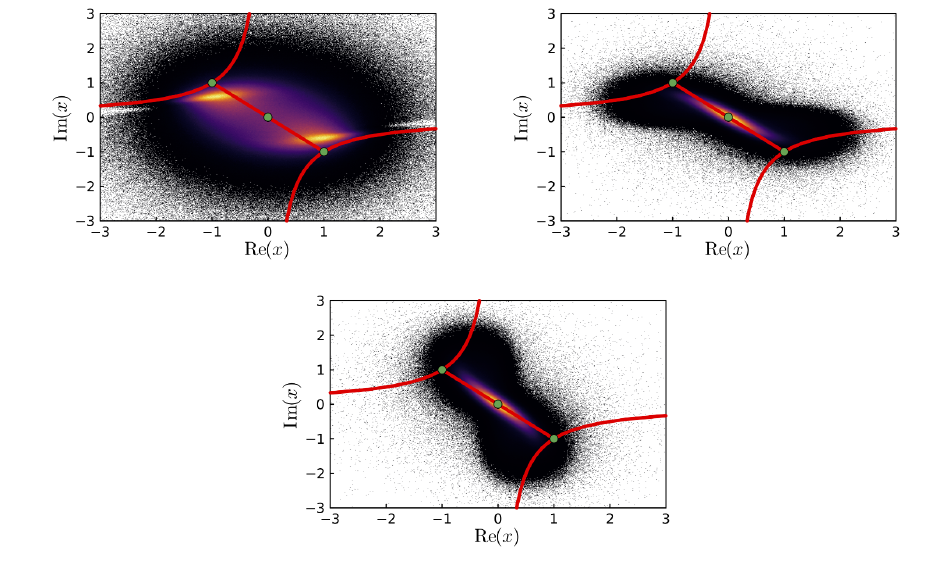
Figure 10 . Distribution of the complex Langevin simulation and the Lefschetz thimble (red line) for the model of eq. (B.1) with σ = 4 i and λ = 2 , using different kernels; K K 1 = exp[ − iπ/ 3] (top right) and K 2 = exp[ − i 2 π/ 3] (bottom). The green points denote the critical points given by the solution to eq. (B.3). The color in the distribution heat map corresponds to the number of samples at the corresponding position (a lighter color refers to a higher value).